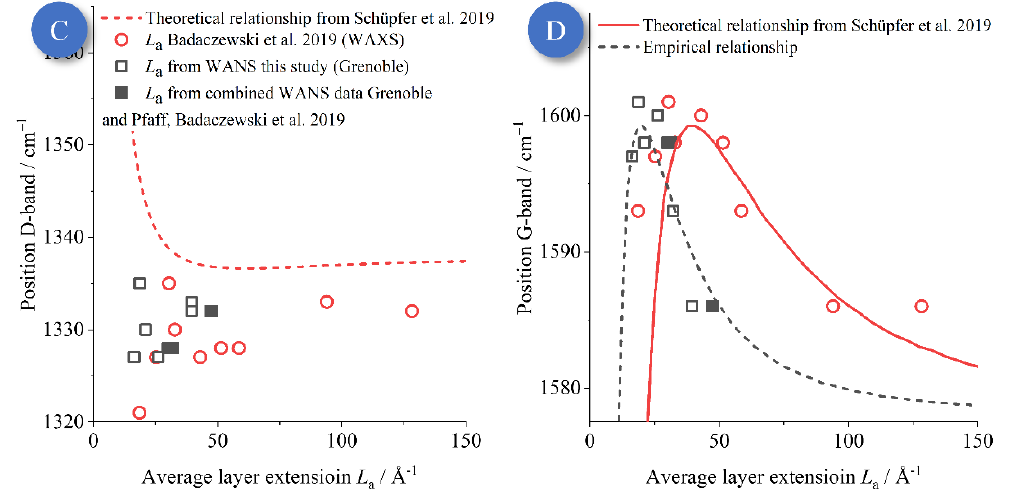
Figure 13. ( A ): Raman spectroscopy data for the phenol-formaldehyde resin-based carbons (PF-R) for different treatment temperatures, using an excitation wavelength of 633 nm. All samples showed increasing 2D and D’ bands and a higher G/D ratio at higher heat treatment temperatures, which are clear indicators for the increase in layer extension and decrease in disorder at higher temperatures [24,25]. ( B ): The intensity quotients I D / I G values were previously determined by Schüpfer et al. [25] and compared to the different L a values determined in this present study and in the work of Badaczewski et al. [37]. ( C ): The position of the D-band was lower than the theoretical values for these resins as determined in ref. [25], indicating that, for (disordered) glass-like carbon, such a theory may not be applicable. ( D ): Position of the G-band related to the L a values obtained from WAXS and WANS. Compared to the previous study of Schüpfer et al. [25], the G-band positions needed to be shifted to smaller L a . In both cases, the Campbell–Fauchet approach was used to model the data, as described by Schüpfer et al. [25,66,67]. A similar figure for the pitches can be found in the SI as Figures S17 and S18.